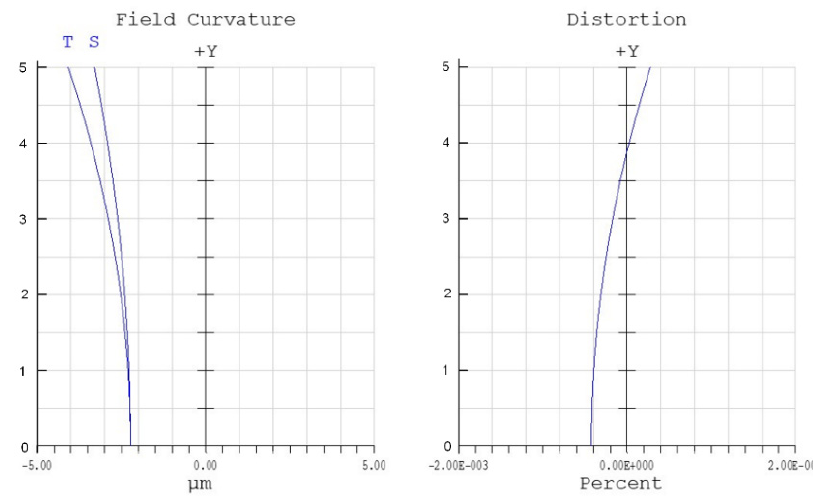
Figure 6. Field curvature and distortion of f - θ lens. The light beam from the collimating lens group should be parallel or approximately parallel light, which must ensure that the object focal plane of the collimating lens group coincides with the image focal plane of the f - θ lens. To obtain a field of view not less than (cid:48) should be: ± 25 ◦ , the focal length of the collimating lens group f 2